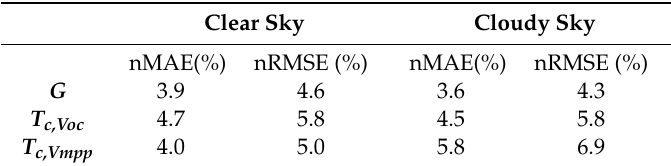
Table 8. Normalized nMAE and nRMSE on computed parameters for the cases of clear sky (Figure 5) and cloudy sky (Figure